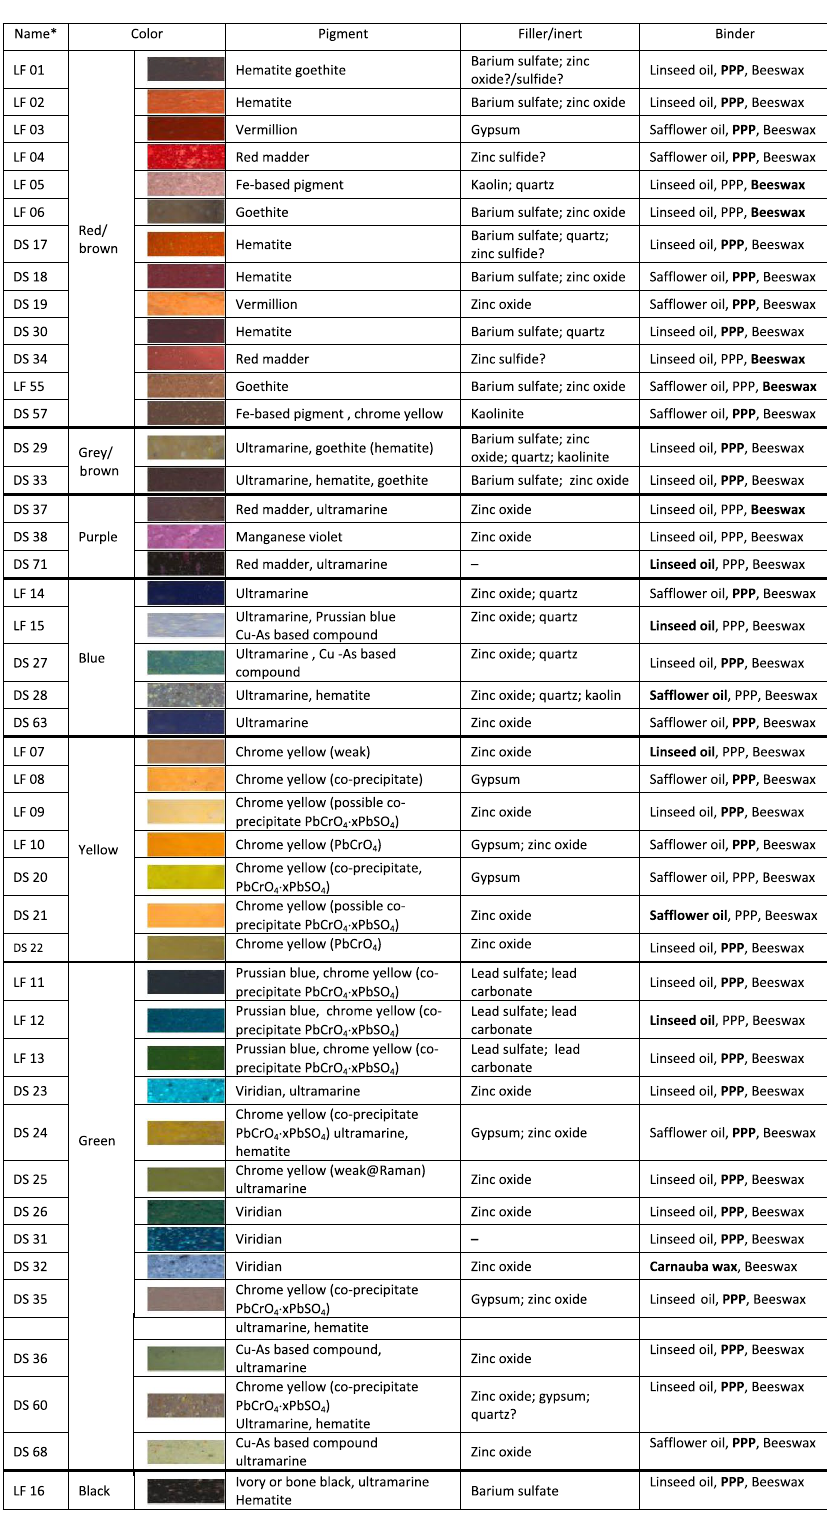
Table 1. List of the 44 pastels and summary of the results from the integrated analytical approach. Colour images are from optical microscope photographs of the microsamples (64 × magnification). Bold: most